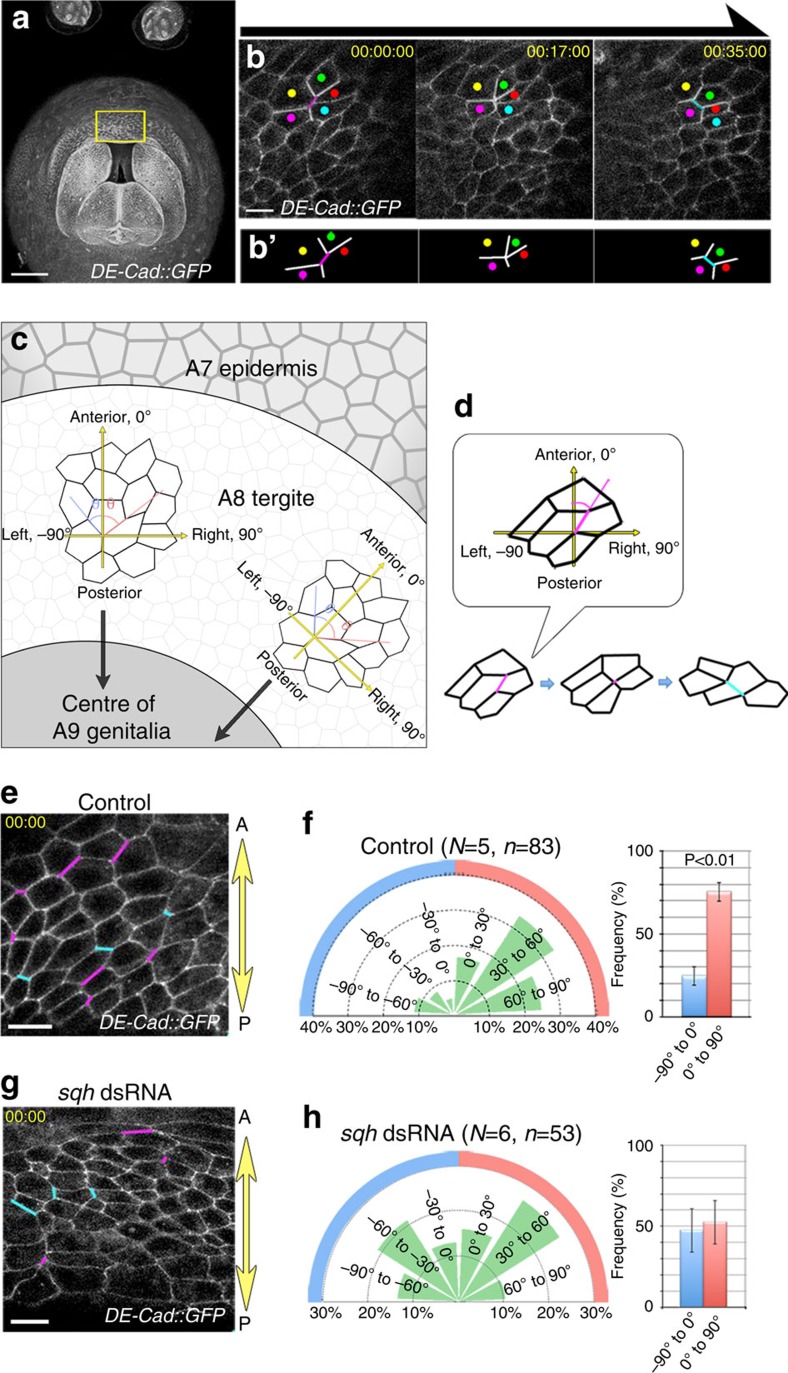
Myo-II-related LR asymmetric cell intercalation in A8a epithelial cells.(a) DE-Cad::GFP was observed at all the cell boundaries at 21 h APF. Yellow-boxed region was magnified in b. Scale bar, 50 μm. (b) Time-lapse images of epithelial cell rearrangement and migration in the A8a, visualized with DE-Cad::GFP. Schematic drawing represents the cell intercalation observed in the upper panels (b'). Scale bar, 10 μm. (c) Schematic drawing of the procedure for analysing the angle (θ) between the line formed by each cell boundary and the AP axis. The AP axis of A8a radiates in all directions from the centre of A9 to the A7 epidermis. Because the A8 tergite forms a ring-like structure surrounding the A9 genitalia at the pupal stage, the AP axis of A8 radiates in all directions from the centre of A9 to the A7 epidermis. The cell boundary angles were classified as being in the −90° to 0° (blue arc) or the 0° to 90° (red arc) range. (d) The angle (θ) formed between each cell boundary undergoing cell intercalation and the AP axis before remodelling was measured. (e,g) Cell boundaries visualized with DE-Cad::GFP in control (e) and sqh knockdown flies (g). The AP axis of the A8 (yellow arrow) was defined as the line from the A7 epidermis to the A9 genitalia. The angle (θ) formed between each cell boundary undergoing junction remodelling, followed by cell intercalation and the AP axis was measured. The cell boundary angles were classified as ranging from −90° to 0° (cyan) or 0° to 90° (magenta). Scale bar, 10 μm. (f,h) Rose diagrams depicting the percentage of cell intercalation axes in the A8a of control flies (f) and sqh dsRNA-expressing flies (h) at 30° intervals of the angle θ during cell movement. The percentage of cell boundaries (showing junction remodelling) with angle θ in the ranges indicated are determined. The frequency of cell intercalation was 13.7% (83/607 in five samples) in the control, and 7.3% (53/726 in six samples) in the sqh dsRNA-expressing flies. Right histograms show the percentage of cell intercalation axes in the ranges indicated. Bars indicate s.d. The numbers of flies and cell boundaries analysed are indicated as N and n, respectively. Fly genotype: DE-Cad::GFP (a,b,e,f), DE-Cad::GFP; AbdB-GAL4 UAS-RedStinger/UAS-sqh dsRNA (g,h).